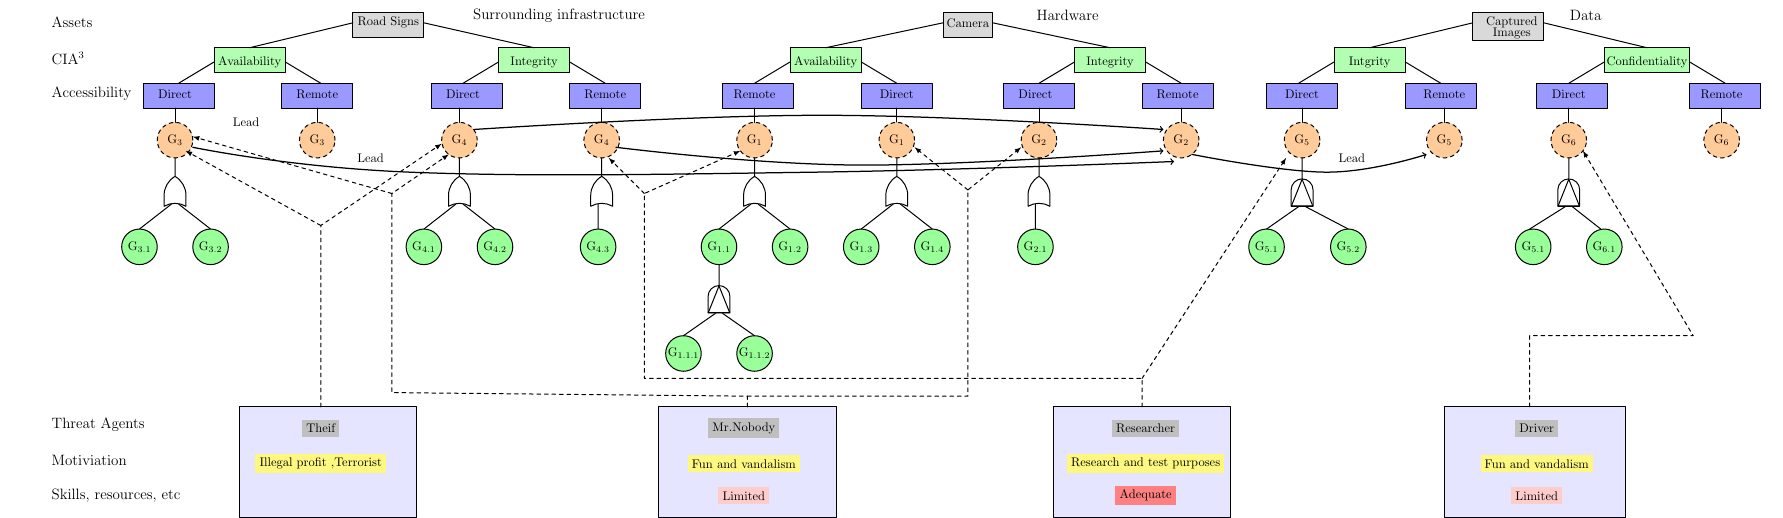
Figure 6. General attack trees for the camera, road sign, and captured images in our